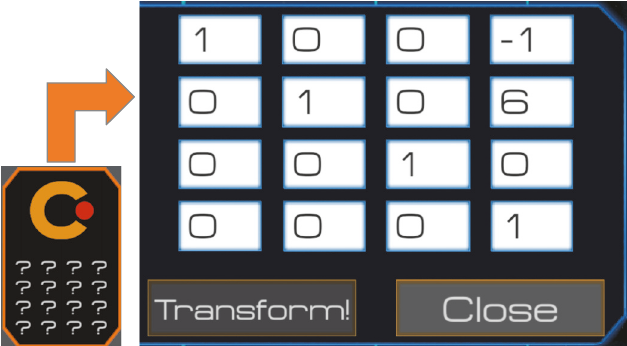
Figure 3: GEtiT allows for the configuration of individual AT operations using the direct value configuration screen. This requires the application of the AT knowledge to correctly determine a desired transformation’s